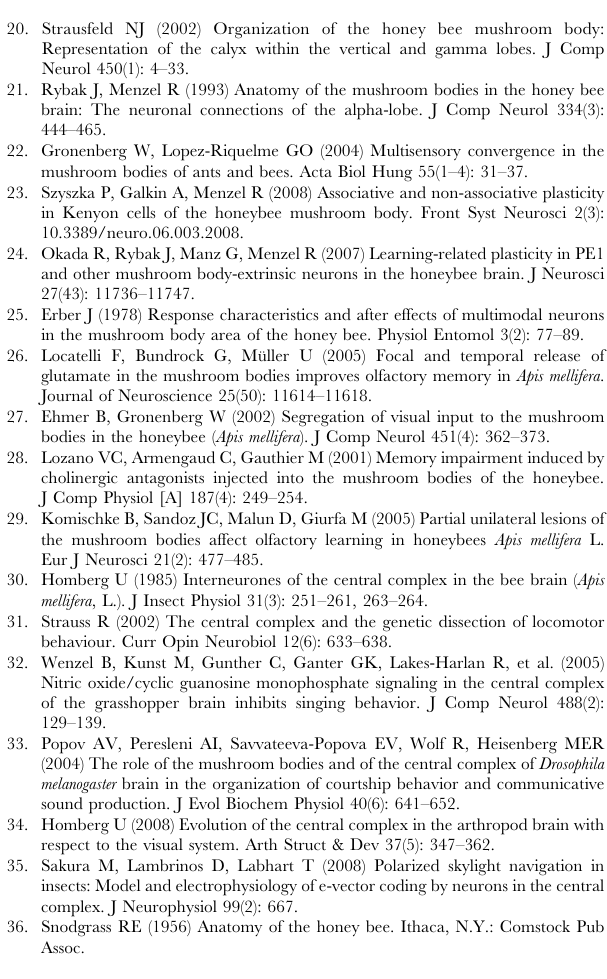
Table S1 ESTs and Gene IDs of honey bee genes from Anova 1 and 2 that had significant differences at FDR ,